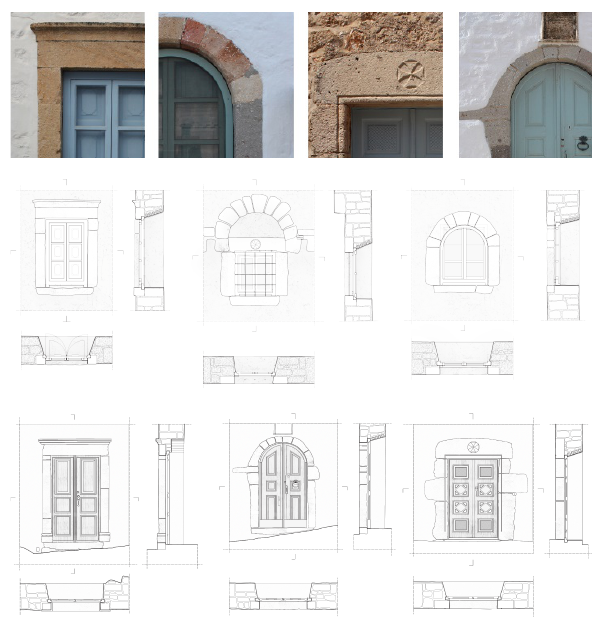
Figure 10. Openings with frame or round arch.